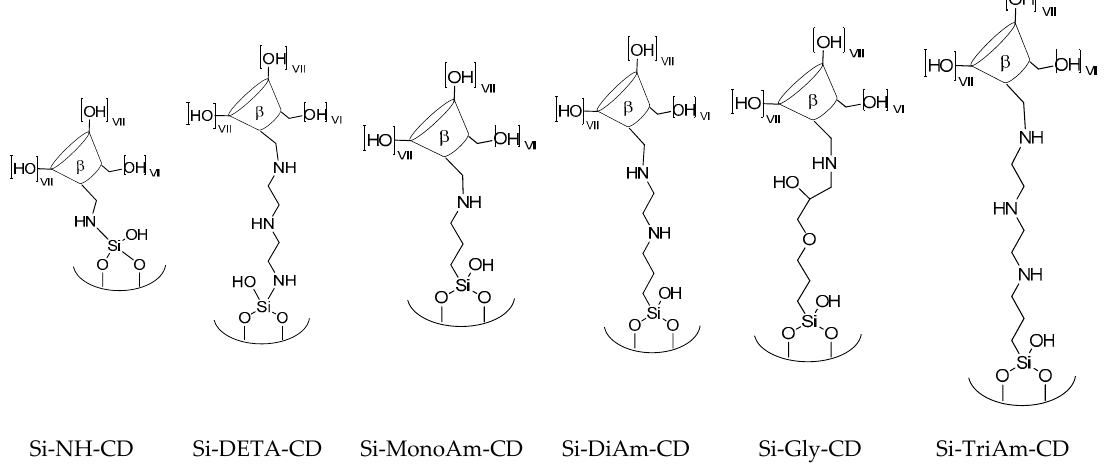
Figure 1. Structures of prepared silica- β -CD derivatives.